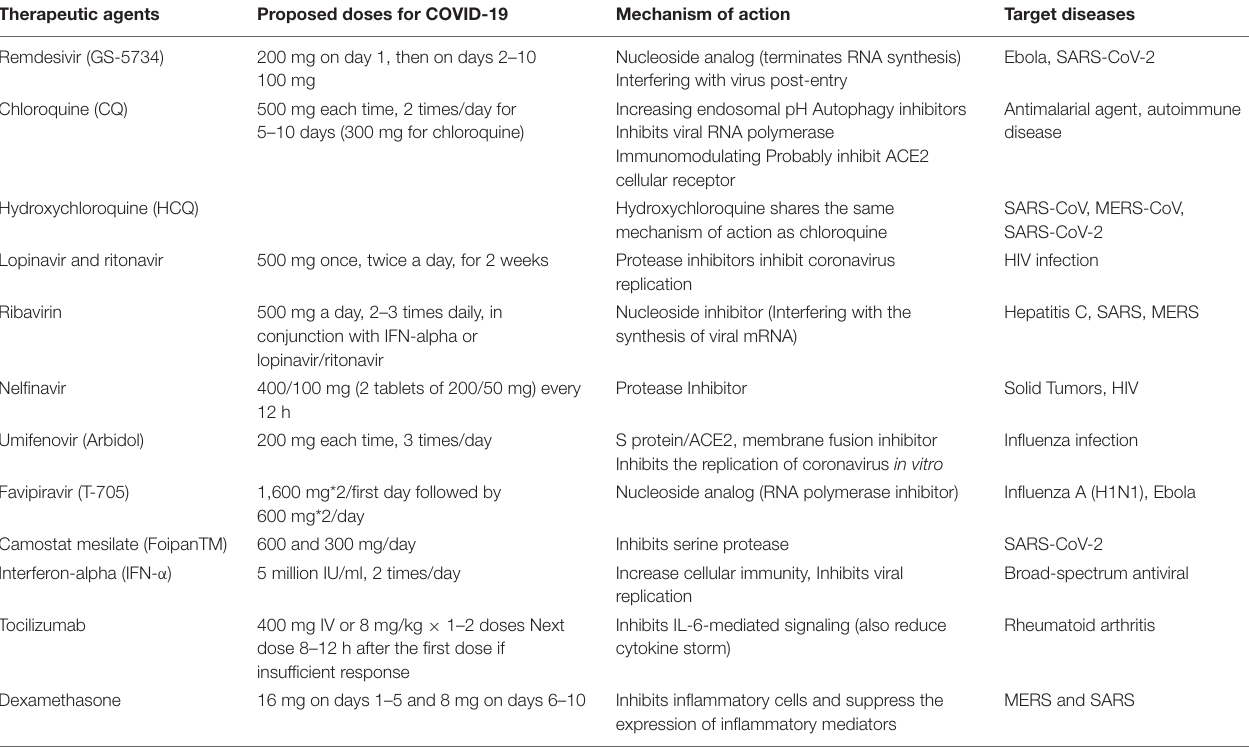
TABLE 2 | Different therapeutic agents used for COVID-19 treatment.